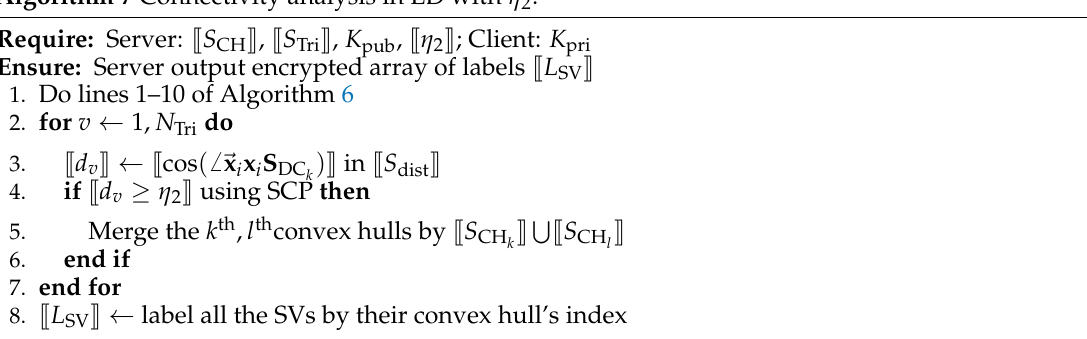
Algorithm 7 Connectivity analysis in ED with η 2